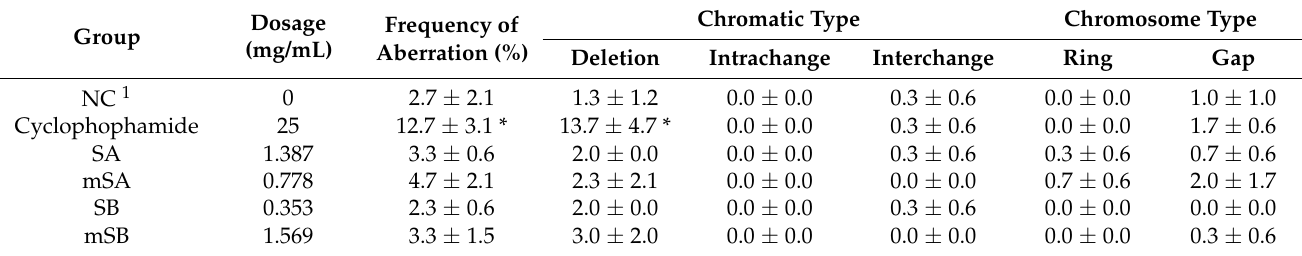
Table 7. Frequency of chromosomal aberration with S9 metabolism of unmodified and modified nano-silica in CHO-K1